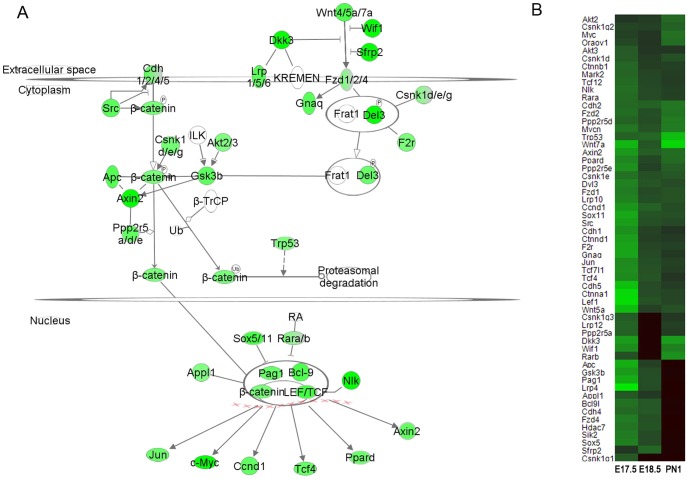
Epithelial Scap deletion in the perinatal lung suppresses Wnt/β-catenin signaling.(A) A schematic representation of mRNAs changed in the canonical Wnt/β-catenin pathway in ScapΔ/Δ perinatal lung (E17.5) is shown. Green nodes indicate mRNAs that were decreased in ScapΔ/Δ lungs with respect to control lungs. Wnt pathway genes that were not changed in response to Scap deletion are depicted as empty nodes. (B) Heatmap demonstrates decreased expression of genes encoding a number of key components in the Wnt/β-catenin pathway in ScapΔ/Δ vs. control mice, n = 3/group.